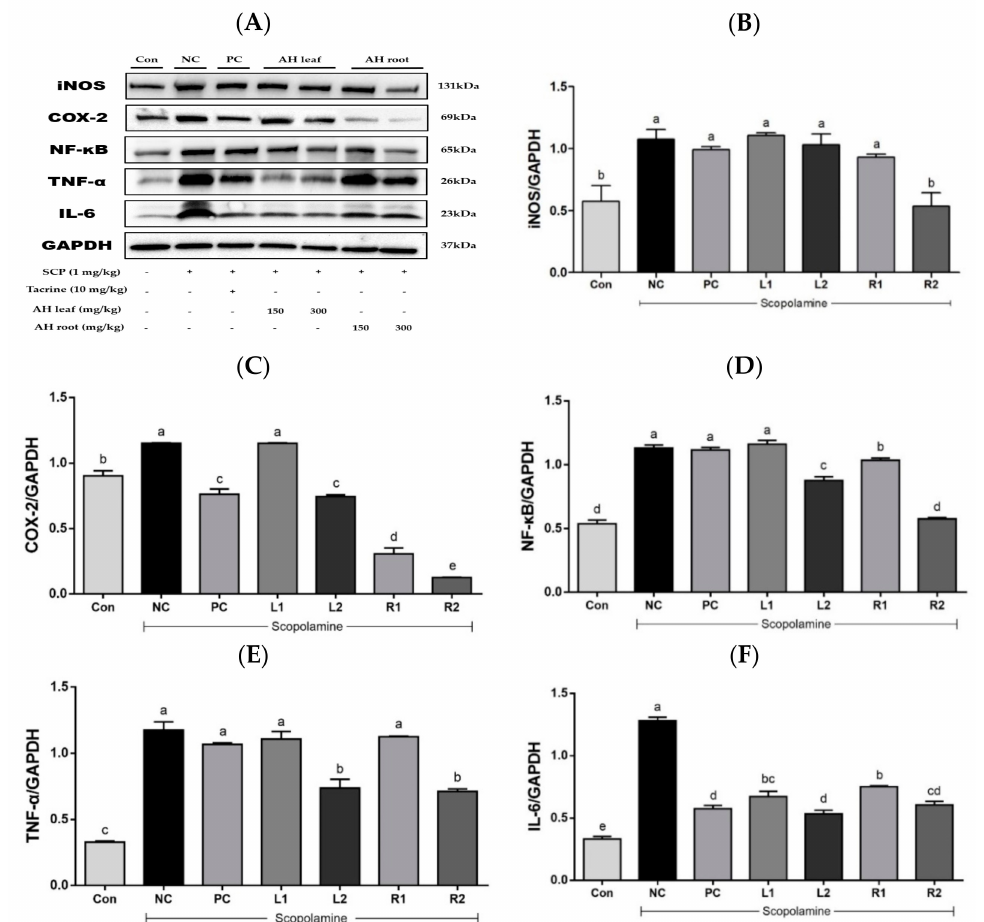
Figure 6. Effects of AH leaf and root extracts on protein expression based on western blot analysis of the liver in C57BL/6 mice with scopolamine-induced memory impairment. ( A ) Protein band image, ( B ) iNOS, ( C ) COX-2, ( D ) NF- κ B, ( E ) TNF- α , and ( F ) IL-6. a–e Differences were considered statistically significant at p <